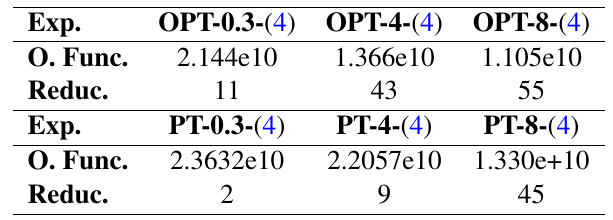
Table 2 Objective function (4) value ( O. Func. ) and percentage reduction ( Reduc. ) of this value regarding the scenario Q =0 given by the experiments ( Exp. ): OPT-0.3- (4), OPT-4- (4), OPT-8- (4), PT-0.3- (4), PT-4- (4) and PT-8- (4).